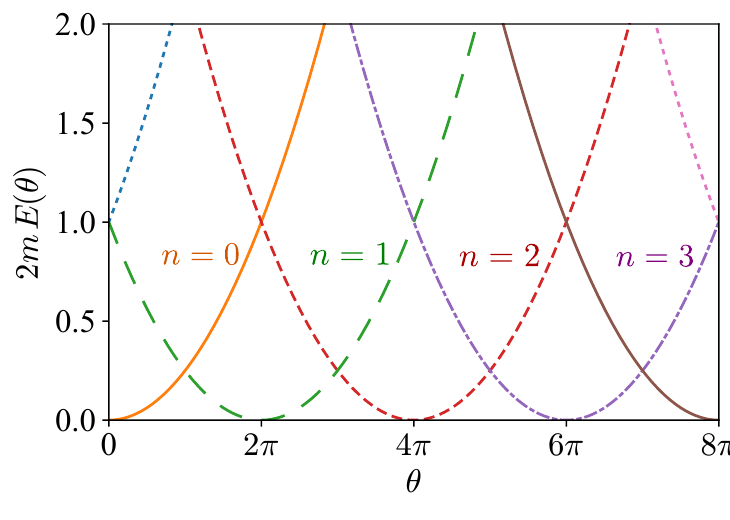
Figure 1 . Eigenenergies E n ( θ ) as functions of θ for various n